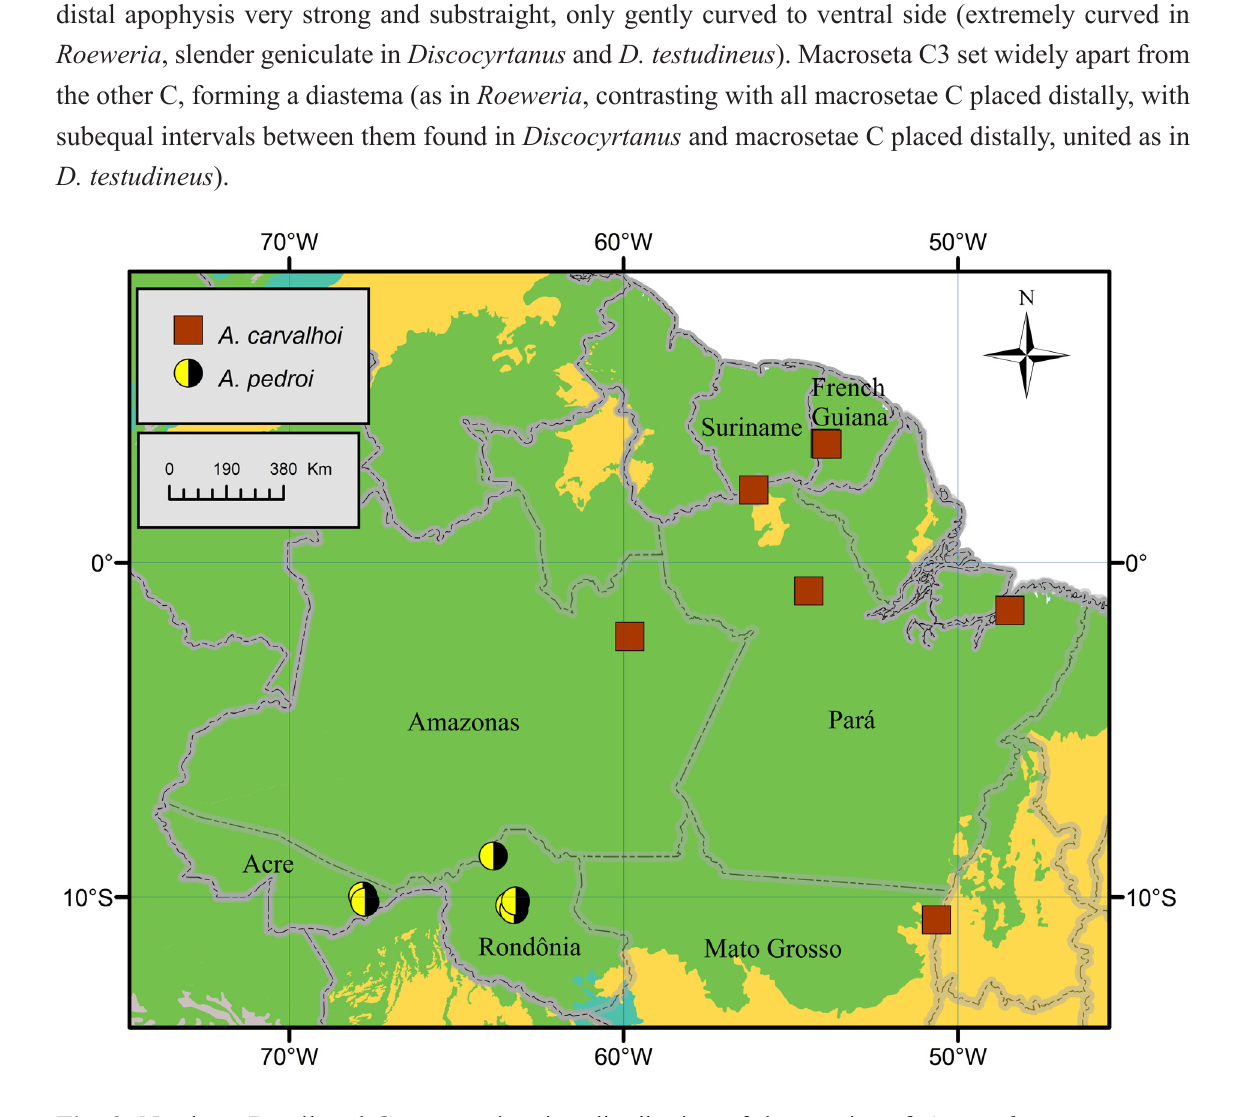
Fig. 2. Northern Brazil and Guyanas, showing distribution of the species of Amazochroma gen. nov. Shaded areas in the background are WWF biomes, green are moist broadleaf forests and orange are grasslands, savannas